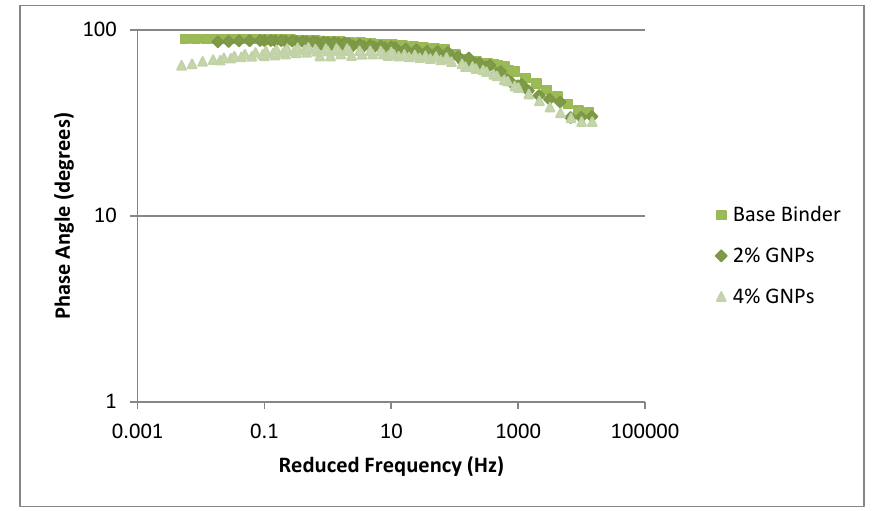
Figure 6. The Master Curve for the Complex Modulus at 50 °C. GNPs = Graphene Nano-Platelets.